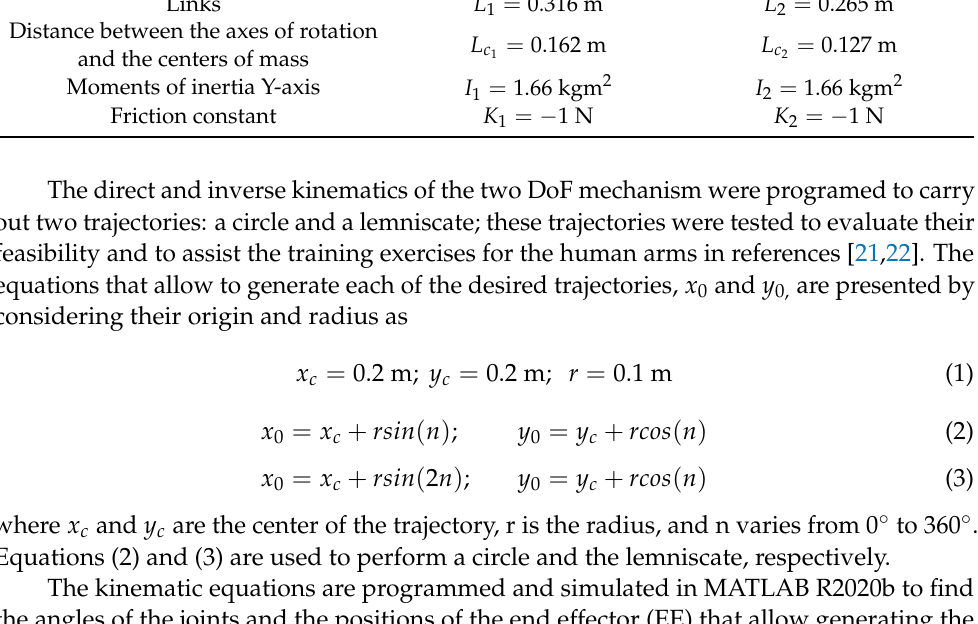
Table 1. Data from an average human arm [22]. Mass Distance between the axes of